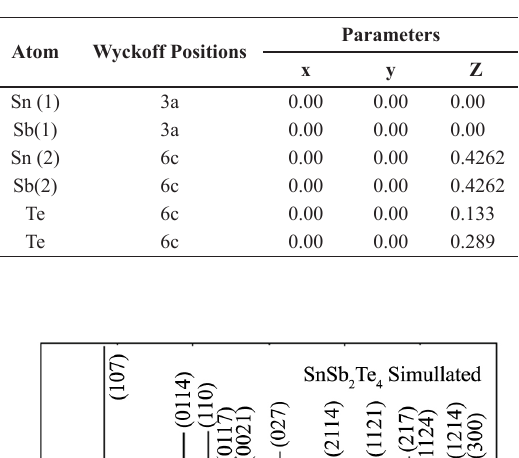
Te which crystallizes 2 4